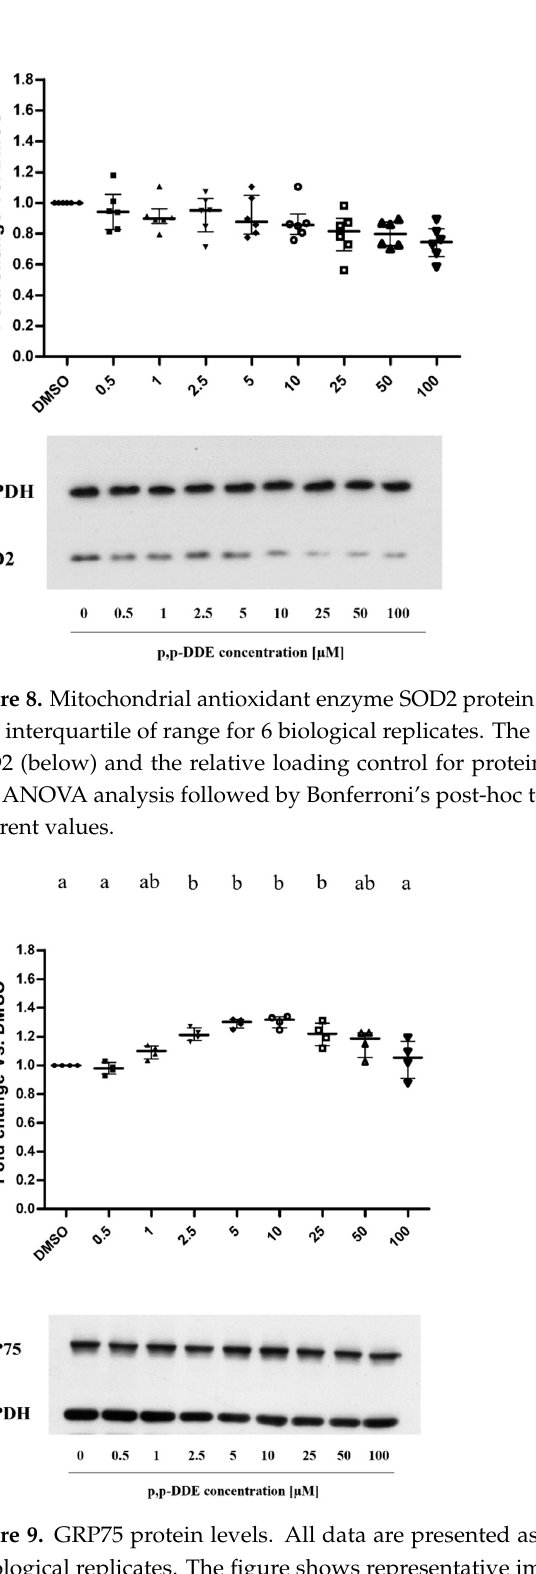
Figure 9. GRP75 protein levels. All data are presented as median with interquartile of range for 4 biological replicates. The figure shows representative images of GRP75 (above) and the relative loading control for protein normalization GAPDH (below). Statistical analyses were performed by using GraphPad Prism software. One-way ANOVA analysis followed by Bonferroni’s post-hoc test: different letters indicate statistically different values.